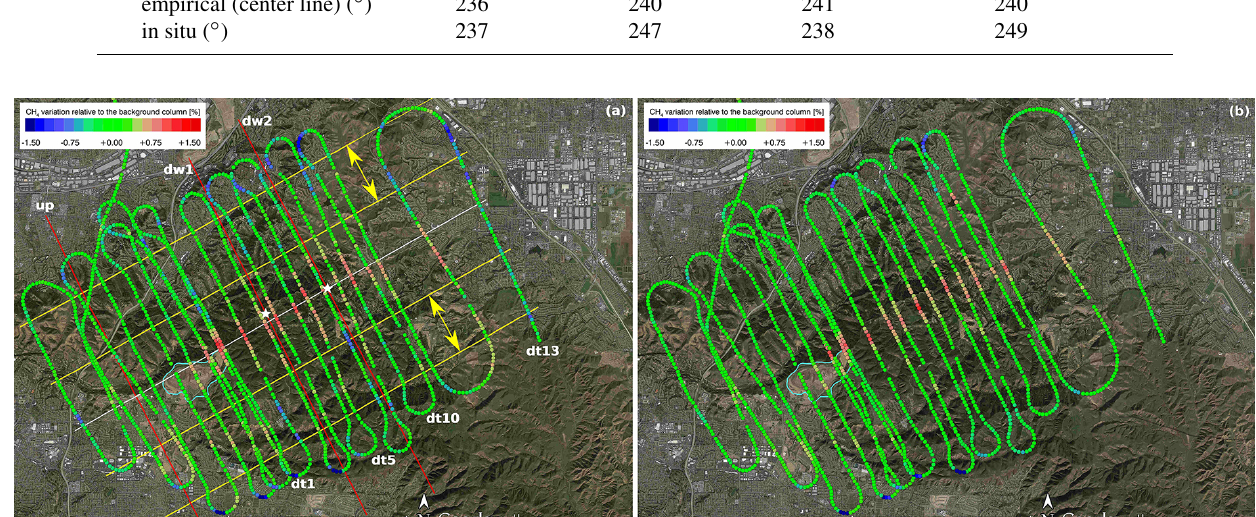
Figure 6. The complete MAMAP remote sensing flight pattern without the inclination filter over the Olinda Alpha Landfill (encircled by the cyan solid line) on 1 September 2014 is shown. The XCH 4 ( CO 2 ) data are smoothed by a 3-point moving average and normalized by a 300- point moving average for visualization purpose only. (a) For reference, the positions of the center line (solid white line), the normalization areas (area between the solid yellow lines emphasized by the yellow arrows), the three flown in situ walls (solid red lines; upwind wall, up; first downwind wall, dw1; second downwind wall, dw2), and labels for the 13 remote sensing downwind tracks (dt1 to dt13) are also depicted. The white stars emphasize the location of the approximate in situ plume location, which corresponds to the origin used in Figs. 5, S7c–f, and S9c and d. (b) Detector-filling-dependency-corrected measurements (for details, see Sect. 3.1.2). The map underneath is provided by Google